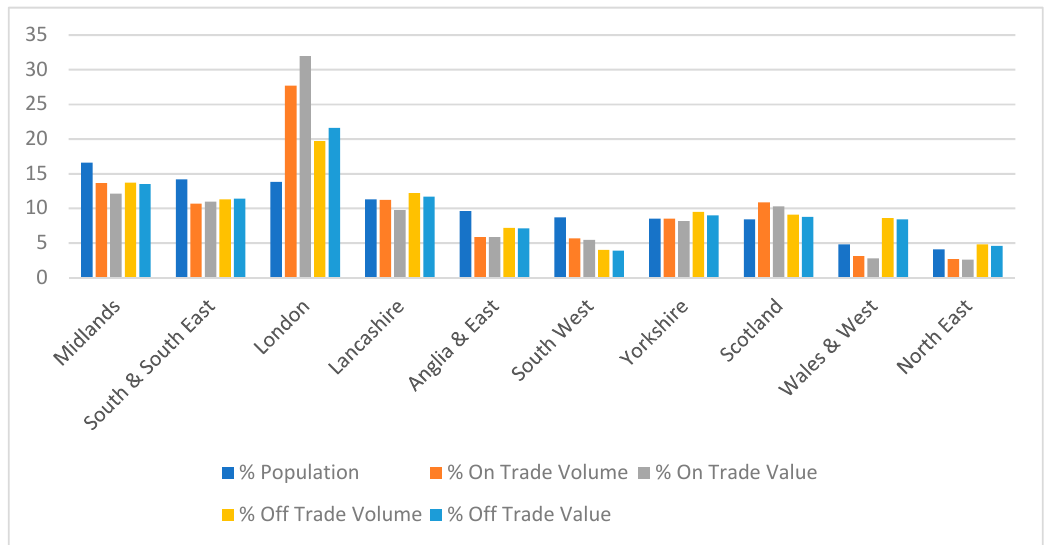
Figure 4. Wine consumption by region of Great Britain relative to population density. Source: Adapted from data supplied by British Beer and Pub Association Statistical Handbook, 2016, and The Statistics Portal (https://www.statista.com/statistics/294681/population-england-united-kingdom-uk-regional/).